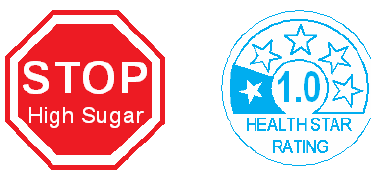
Figure 5. T he two non-control levels of the FoP label independent variable. These were sized to occupy 3% of the prime facing of each product. The third treatment was a no label control.